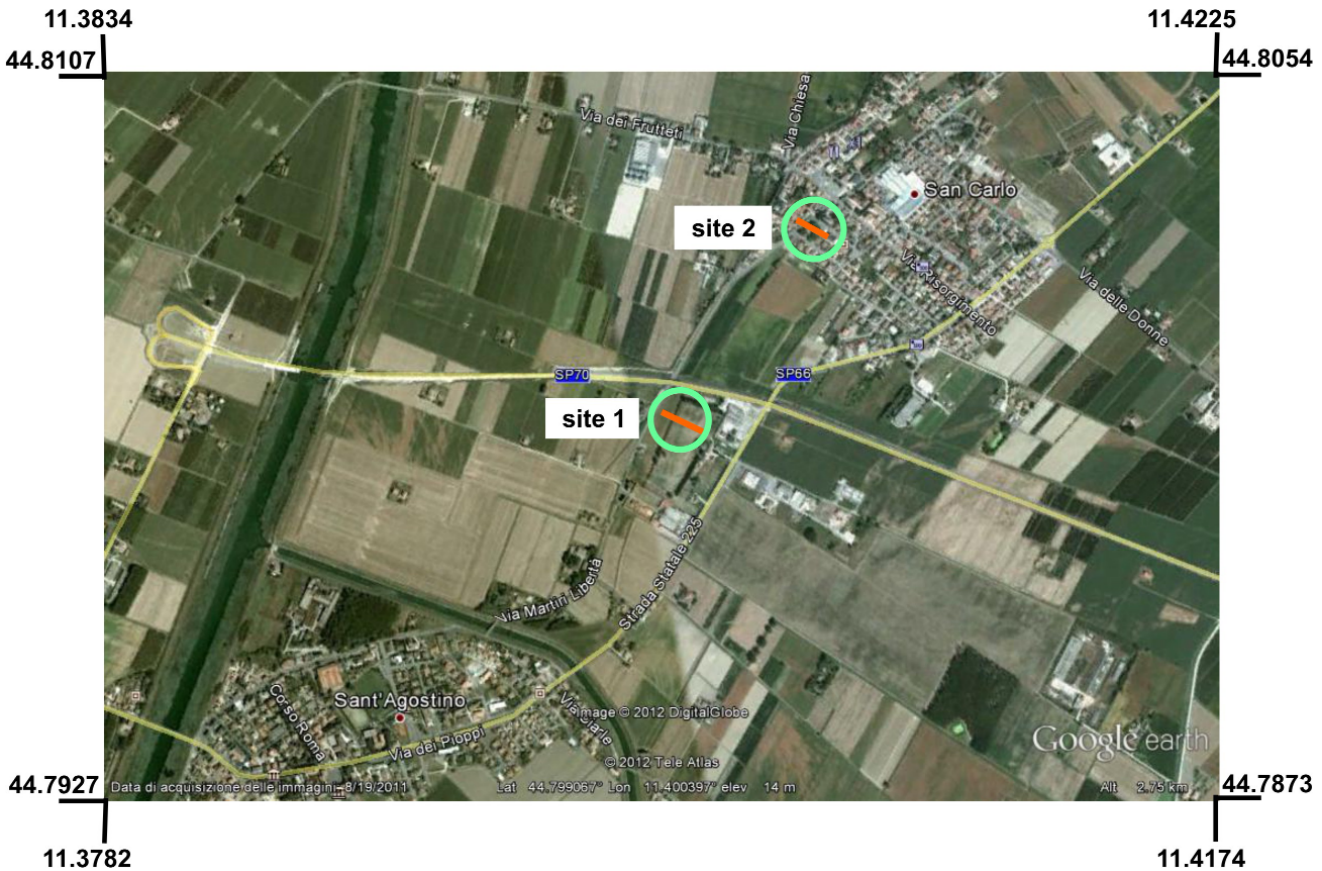
Figure 1. Location map of the two sites investigated using electrical resistivity tomography and presented in this study. Satellite picture from Google